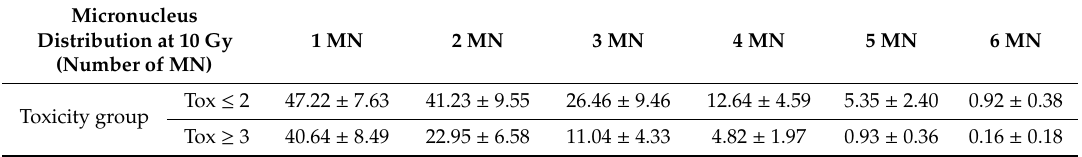
Table 3. Micronucleus distribution at 10 Gy in both groups of patients. Groups Tox ≤ 2 and Tox ≥ 3 correspond to patients presenting grade 2 or less and grade 3 or more of late skin reactions after RT according to RTOG / EORTC,